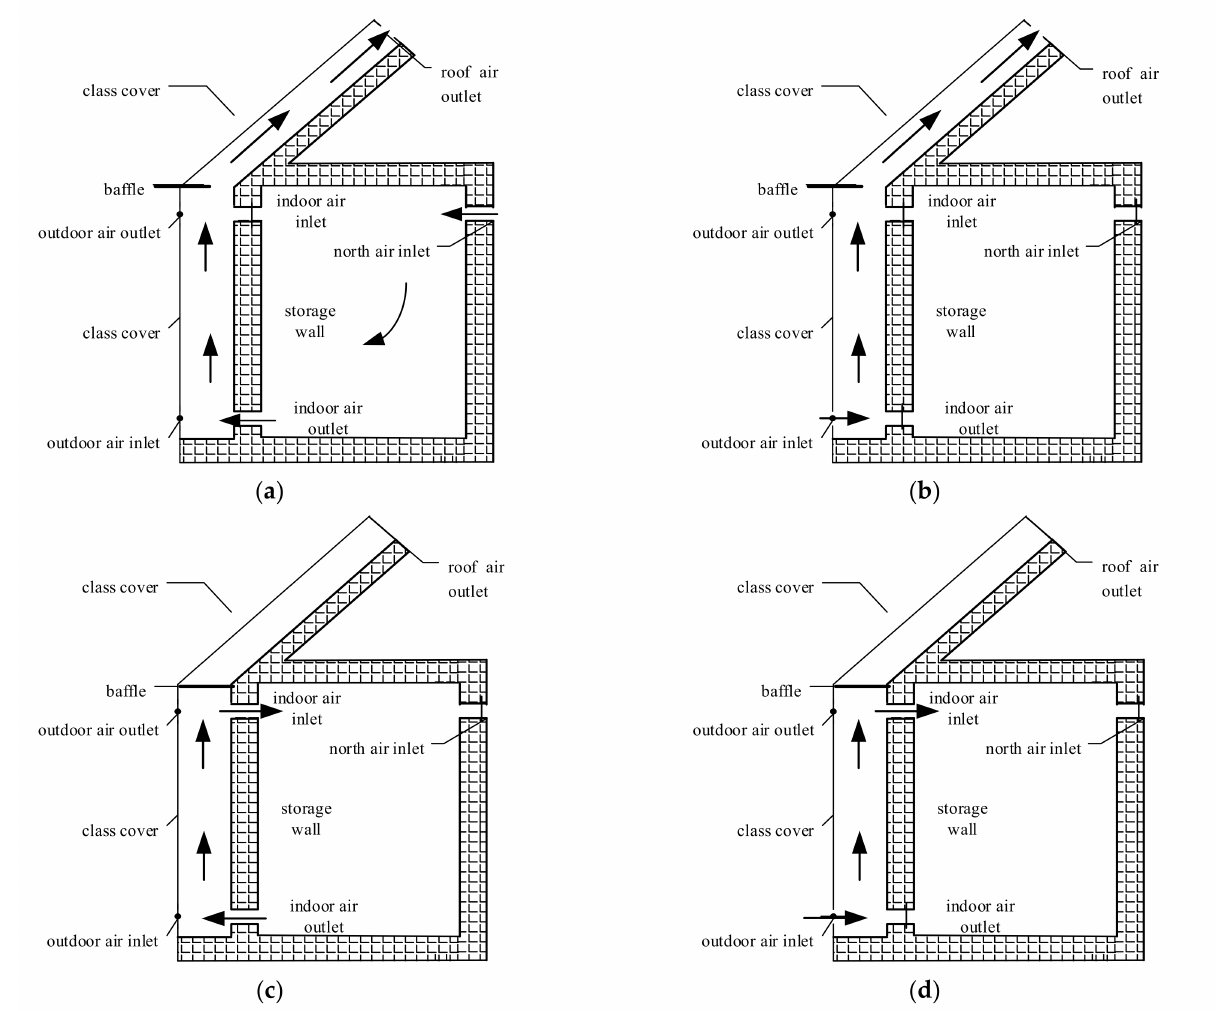
Figure 1. Schematic diagram of a combined solar chimney: ( a ) summer natural ventilation mode (S1); ( b ) summer anti-overheating mode (S2); ( c ) winter space heating mode (W1); and ( d ) winter preheating mode